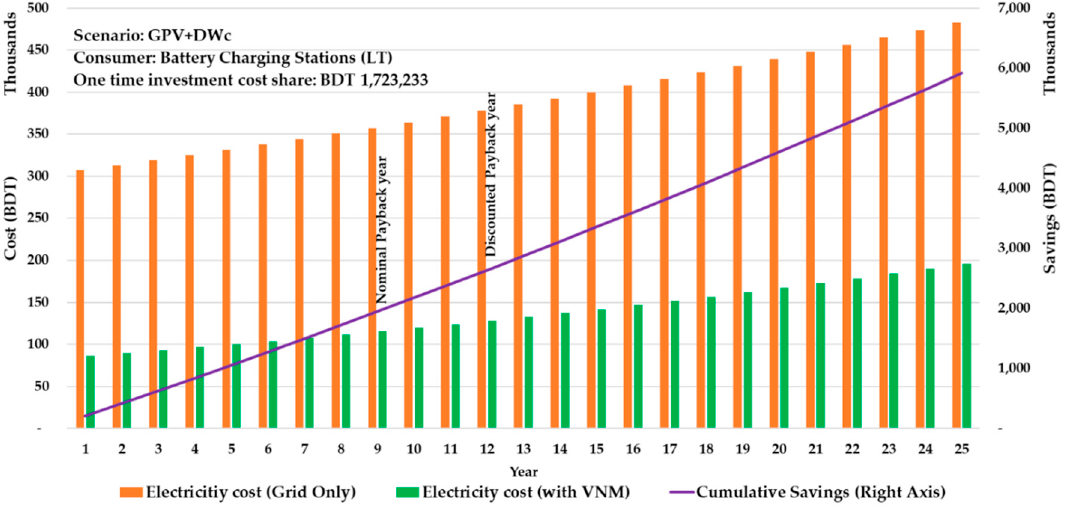
Figure 8. Annual electricity cost comparison between grid‑only and with VNM for charging station consumers. Cumulative savings at the end of RSPP life is 5.91 Million BDT Table 10. Average annual consumption, consumer-wise RSPP capacity shares and estimated costs.